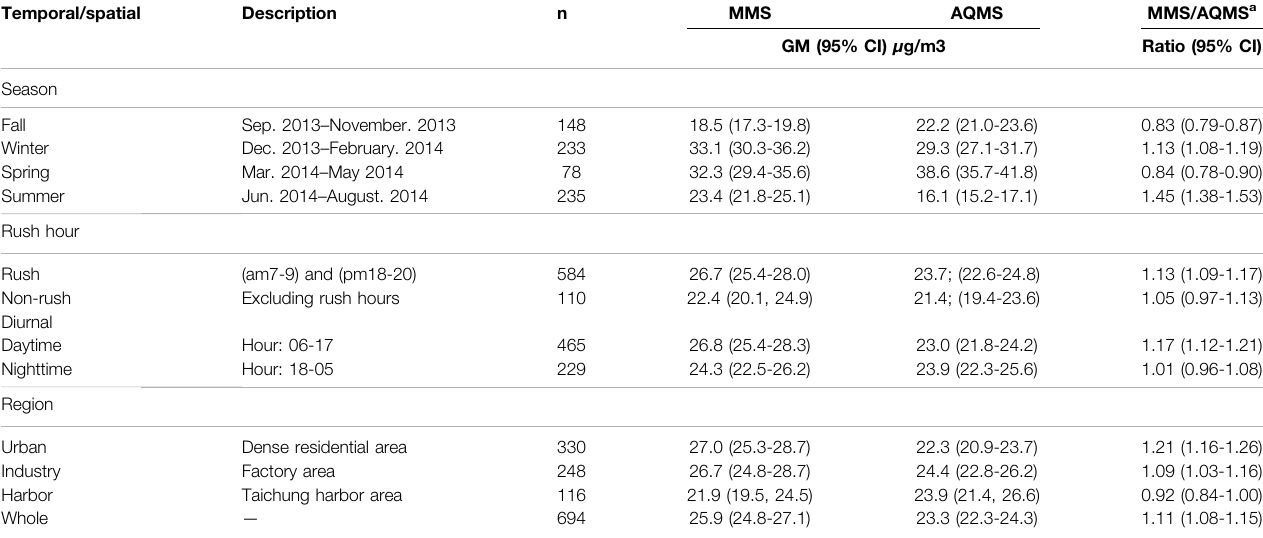
TABLE 4 | Comparison of PM 2.5 concentrations of the whole sampling year, seasonal, diurnal, and rush/non-rush hour for data obtained from both the AQMS and MMS.